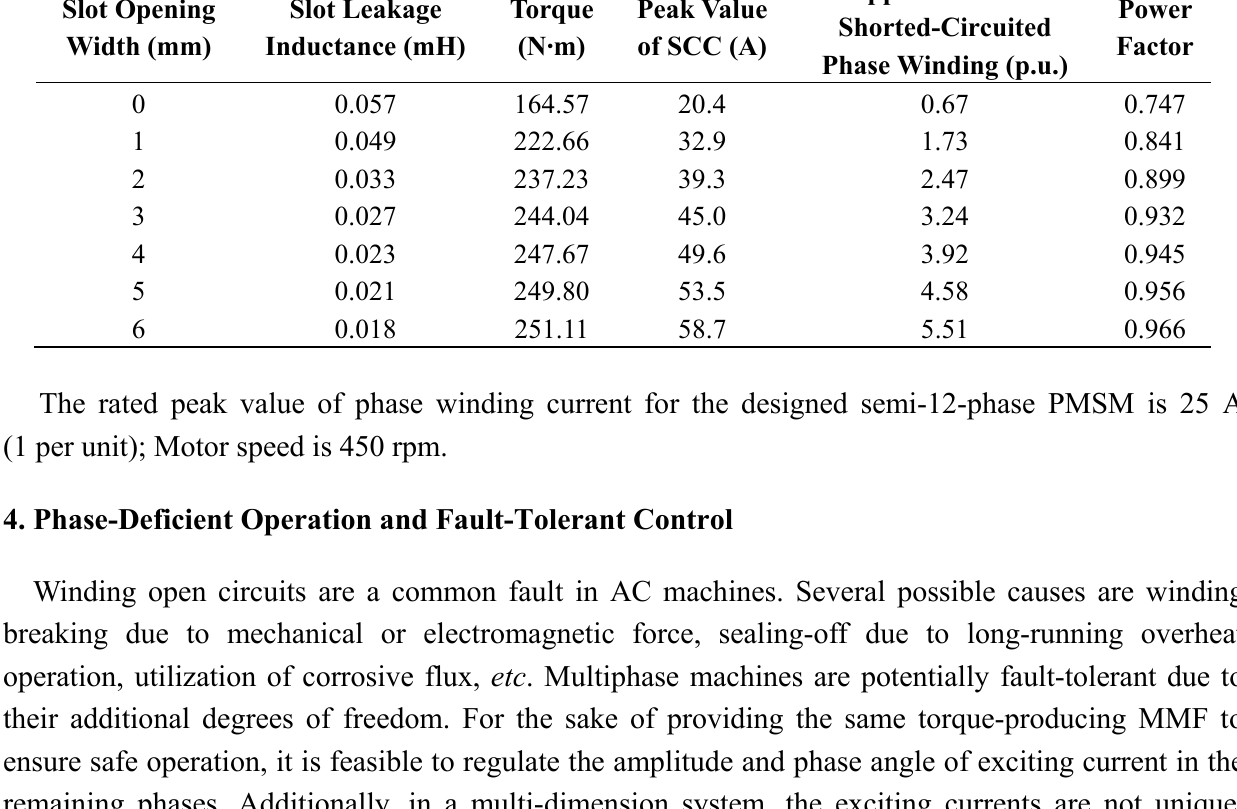
Table 5. Performance comparison in short-circuit faulty mode with varying slot opening width. Slot Opening